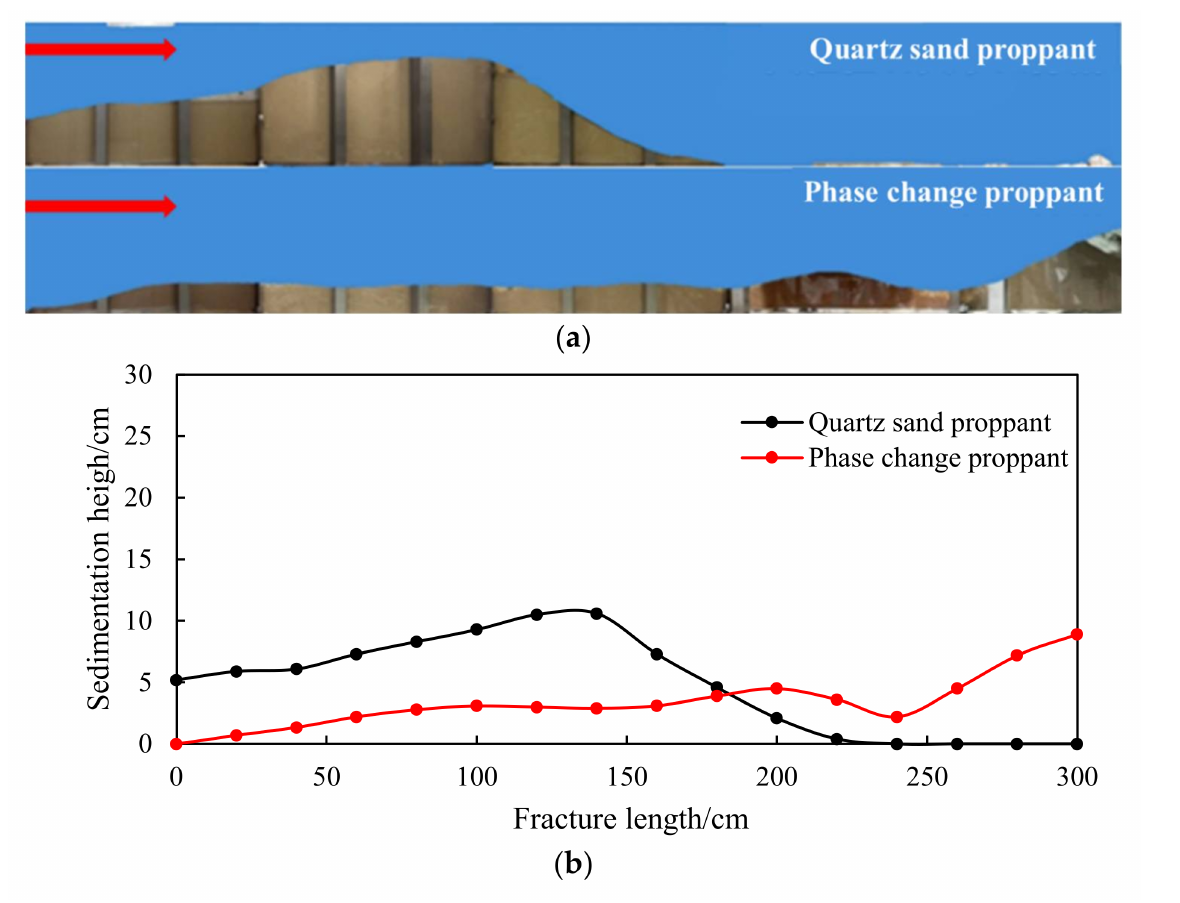
Figure 22. Experimental results and data of proppant migration. ( a ) is the proppant migration experimental results; ( b ) is the data of experimental